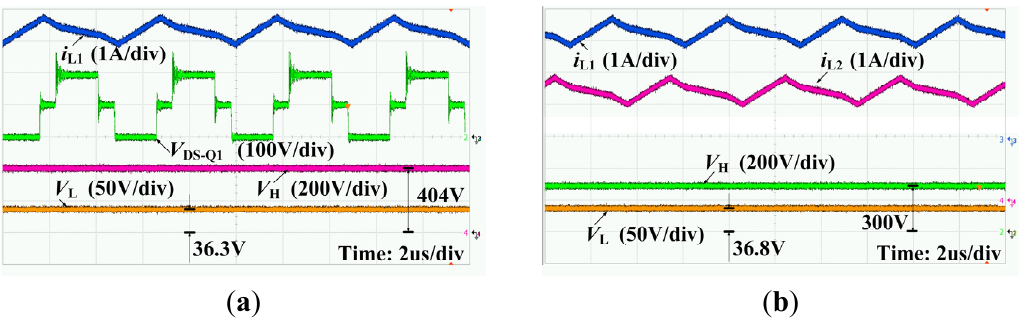
Figure 18. Experimental waveforms under CCM Buck stage ( a ) 400 V to 36 V ( b ) 300 V to 36 V.